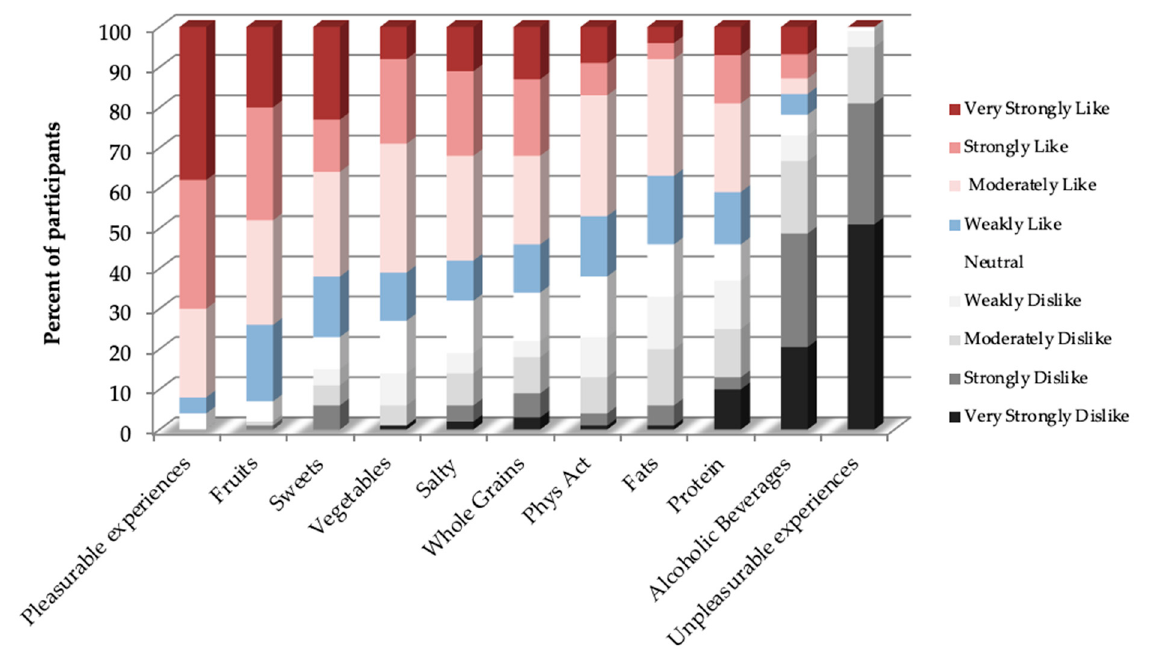
Figure 2. Percentage of women in each group ordered between most liked ( left ) to most disliked ( right ) groups on the liking survey at baseline (adds to 100% within a group).